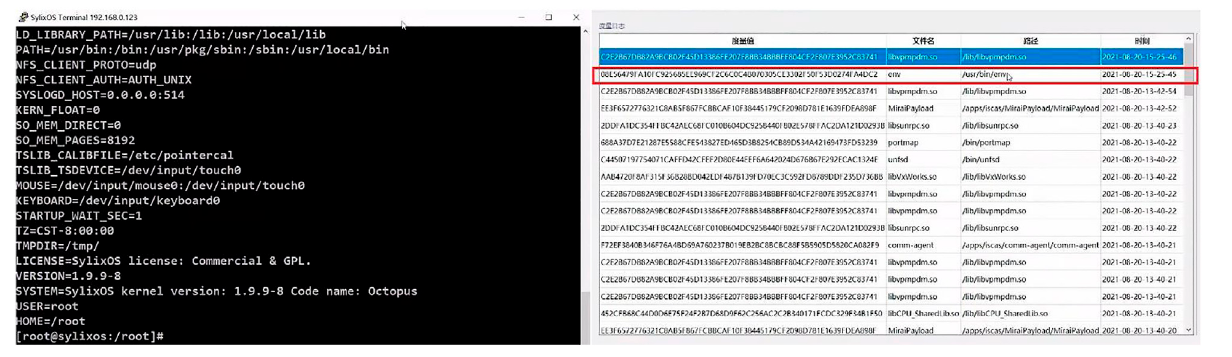
Frontiers in Energy Research |